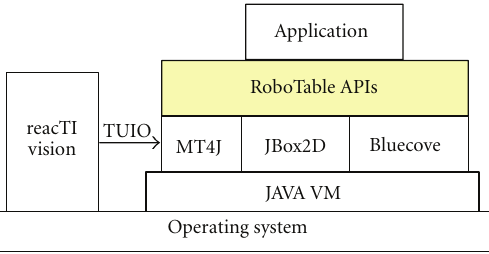
Figure 5: Software